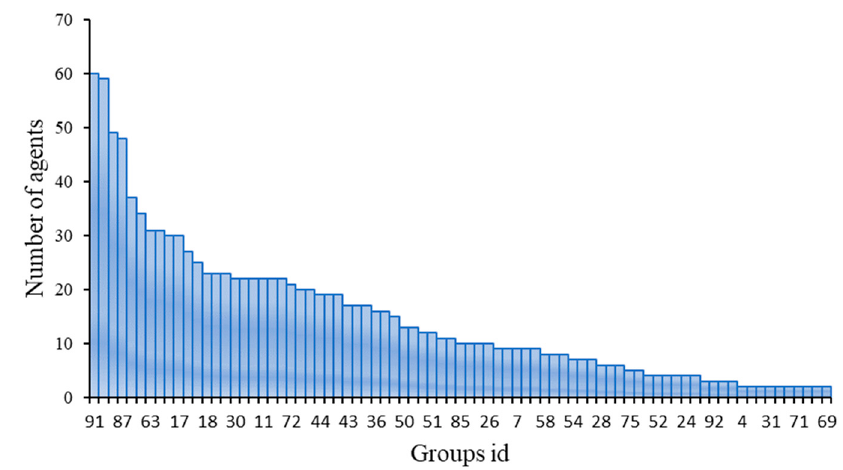
Figure 2. The number of agents contained in different groups.